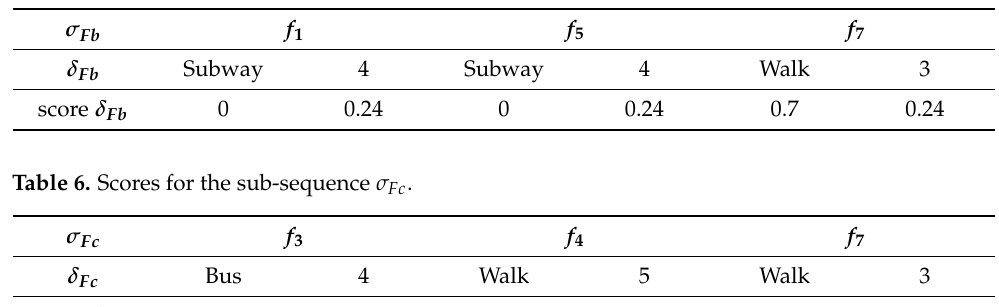
Table 5. Scores for the sub-sequence σ Fb .